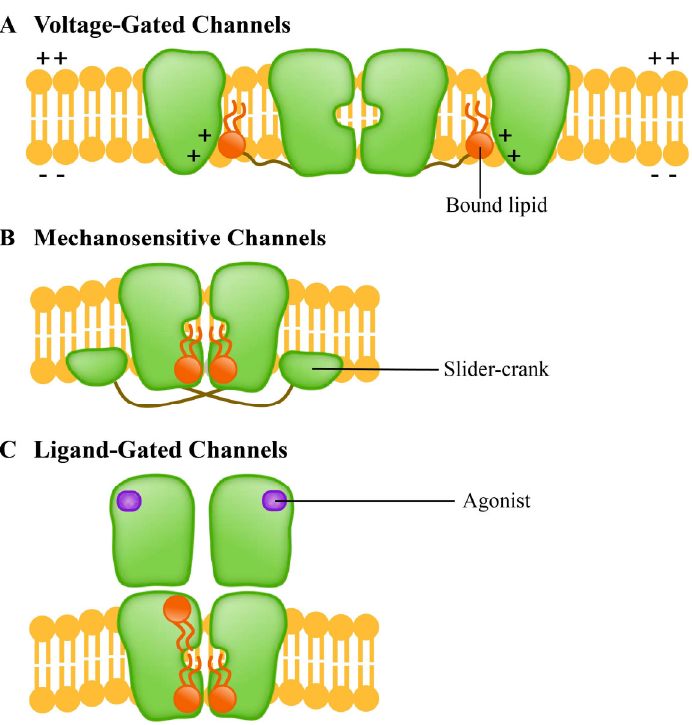
Figure 9. Different ion channel protein families have different lipid response patterns. ( A ) Voltage- gated channels (voltage-gated channel) is a tetramer; ( B ) Mechanosensitive channels (mechanically sensitive channel) uses the “crank slider” mechanism to convert increased double-layer tension into channel gating; ( C ) Ligand-gated channels (ligand gated channel) affects the function of TM helical stacking to change the channel function.